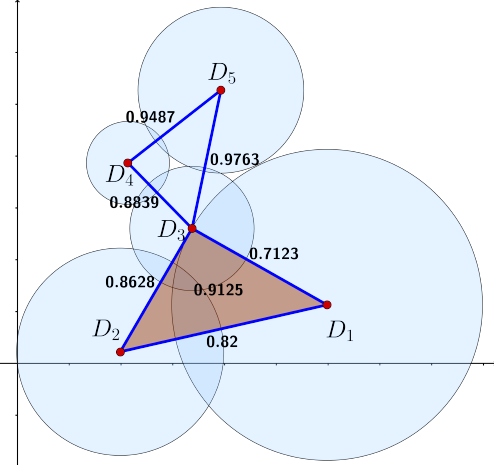
Figure 2. The ˇCech-weight function of the 2-disk system M